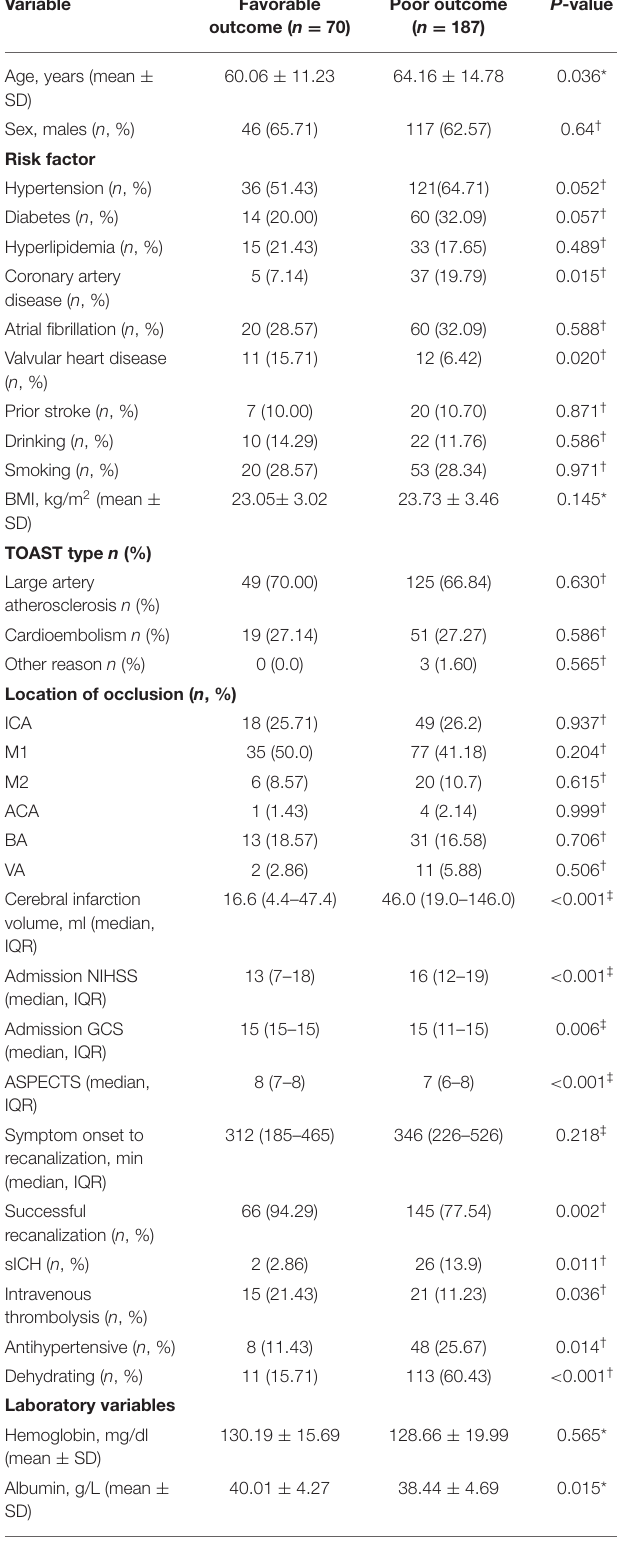
TABLE 1 | Baseline Characteristics according to 3-month